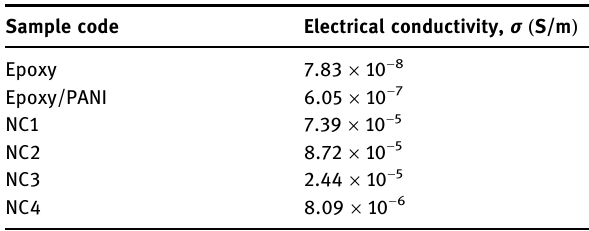
Table 3: Electrical conductivity of epoxy, epoxy/PANI, and